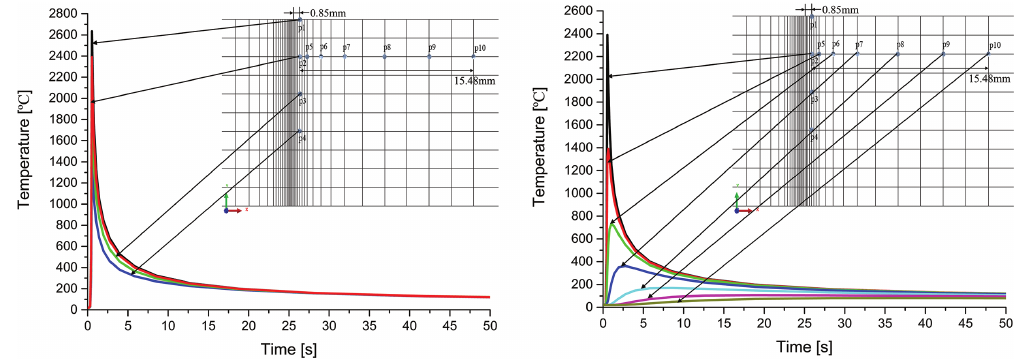
Figure 10: Temperature vs time curve, (a) for differ- ent depth points and (b) for same depth of different